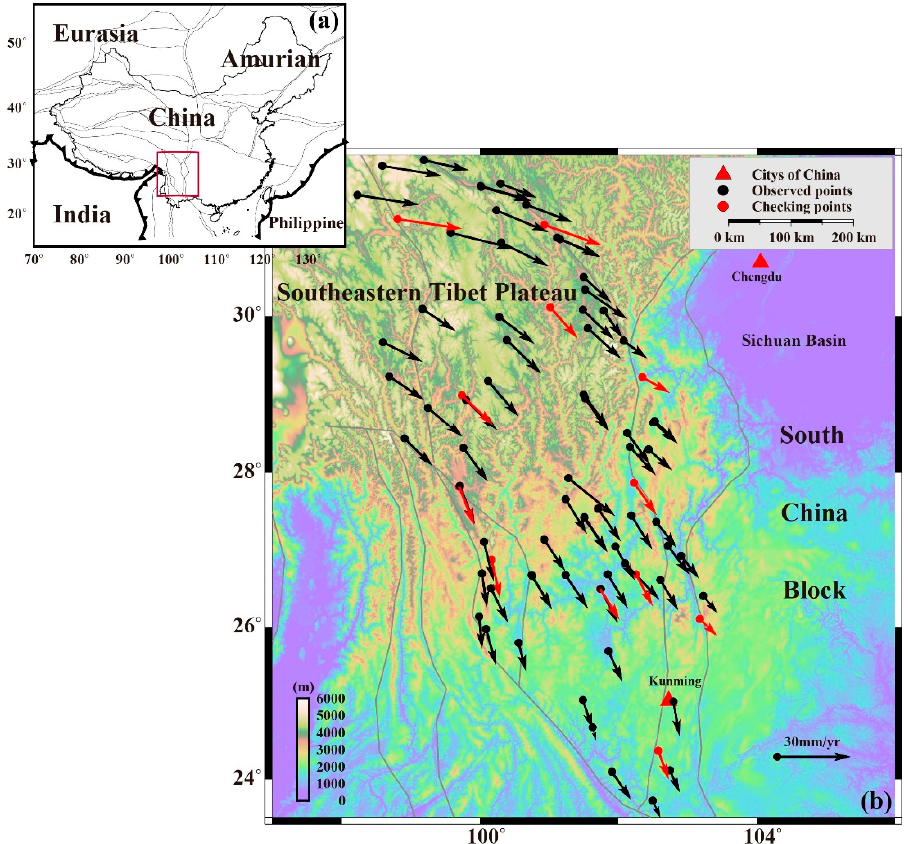
Figure 2. The GPS velocities for 1999-2013 (mm/a) and the location of the Sichuan-Yunnan block. Red rectangle outlines the study area in mainland China ( a ). Gray solid lines represent the major faults [29] ( b ). Red triangles represent major cities (capital cities) ( b ). Black arrows are the observed GPS velocities, and the red color at the GPS station represents the checking points ( b ).